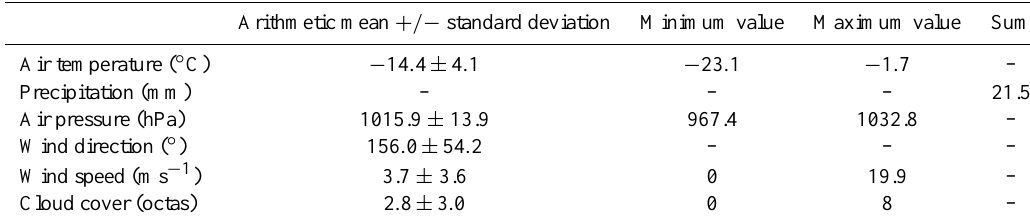
Table 1. Meteorological average conditions during the water sampling period (15 February to 7 March 2010) measured at Ny- ˚Alesund and provided by the Norwegian Meteorological